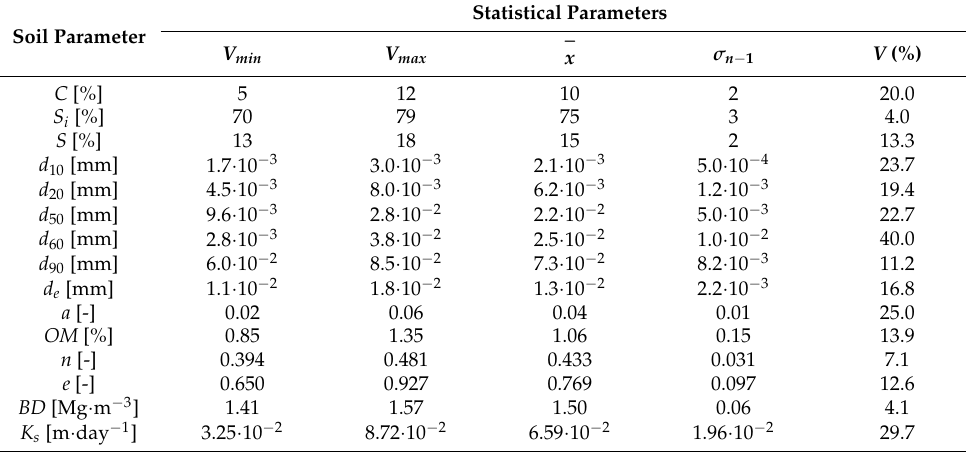
Table 2. Statistical values of parameters for determination of saturated hydraulic conductivity by means of thepedotransfer functions.